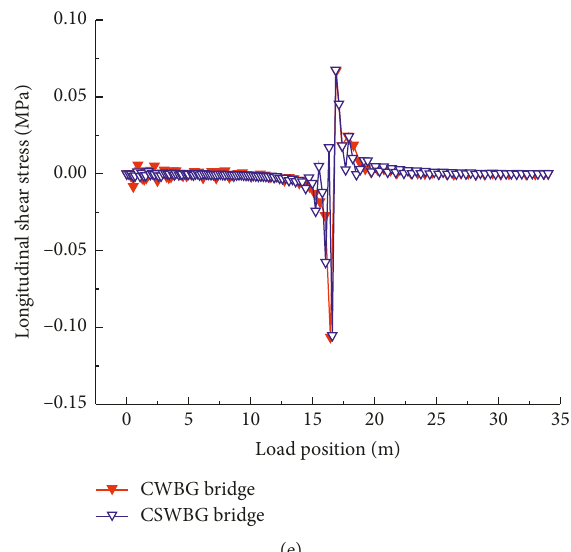
Figure 13: Comparison of longitudinal shear stress between layers of the bridge deck pavement of both models. (a) CWBG bridge. (b) CSWBG bridge. (c) 36 km/h. (d) 72km/h. (e) 108km/h.